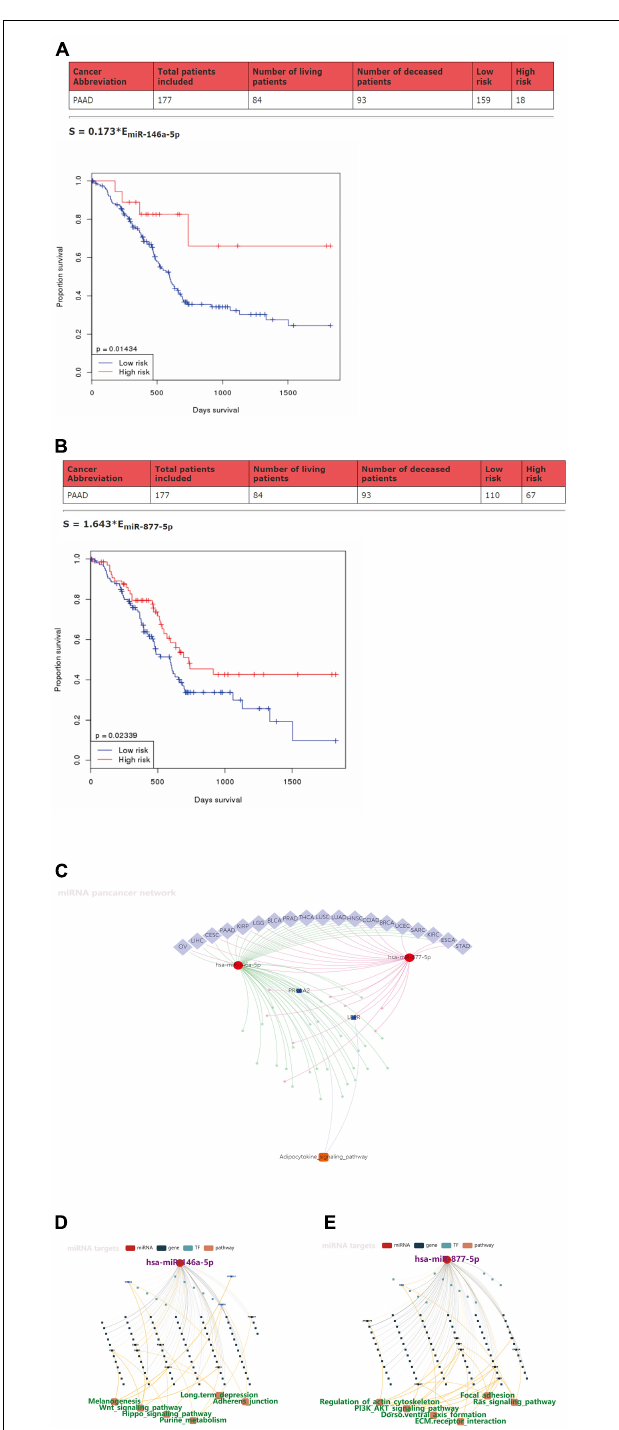
FIGURE 5 | Prognostic values of miR-146a-5p/miR-877-5p and the signaling pathways that may be involved in downstream targets in PDAC. (A,B) Kaplan–Meier survival analysis of miR146a-5p and miR-877-5p expression in pancreatic cancer based on OncomiR datasets. (C) Pan-cancer microRNA-gene-pathway network from miRNACancerMAP. (D,E) Regulatory networks of miR146a-5p/miR-877-5p and associated signaling pathways of putative targets in PDAC from